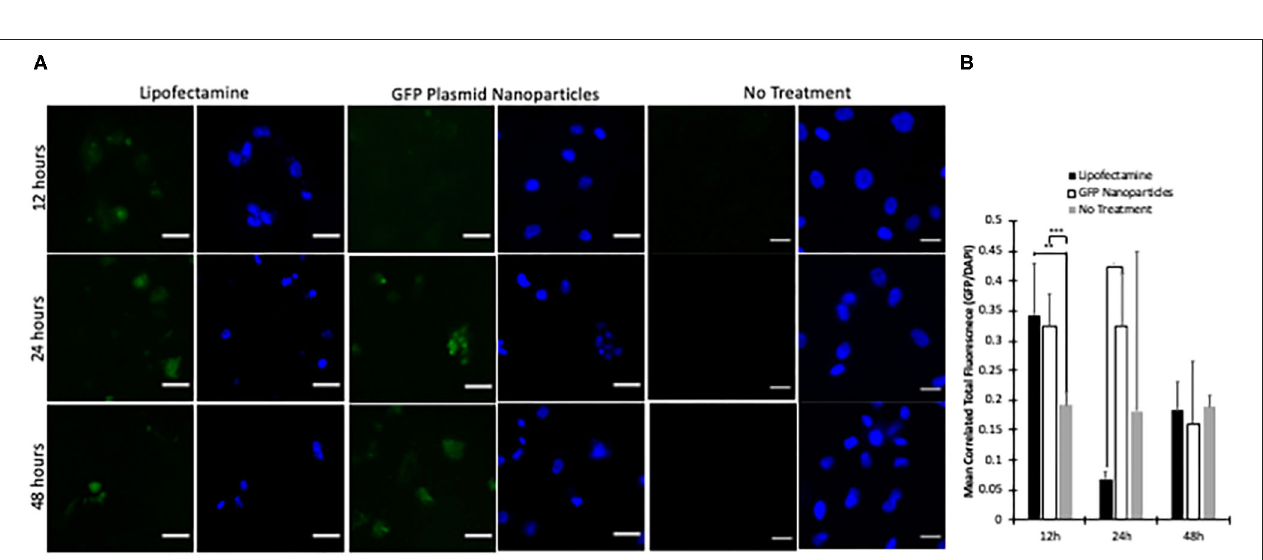
FIGURE 6 | GFP plasmid-loaded nanoparticle transfection. (A) After 6h of treatment, nanoparticles or lipofectamine were washed off with 1X PBS and media replaced. At 12h, slight GFP expression can be seen ( A , first row). After 24h, there is significantly more GFP expression in GFP plasmid-loaded nanoparticles than lipofectamine treated cells ( A , second row). Additionally, after 48h, lipofectamine transfected cells had a high GFP signal in few cells. Whereas, nanoparticle transfected cells had many cells expressing GFP, resulting in a lower over signal. (B) Normalized GFP intensity to nuclei intensity shows significantly higher lipofectamine at 12h, significantly higher Nanoparticle at 24h, and no difference at 48h. • indicates ( p < 0.1), **indicates ( p < 0.01) and ***indicates significance at ( p < 0.001) via one-way ANOVA per time point.